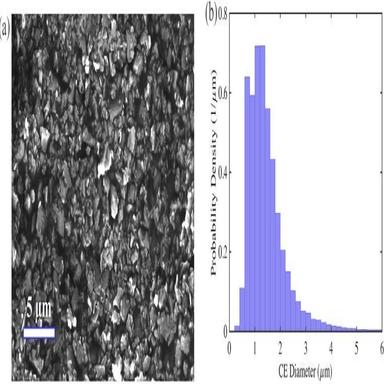
(a) Scanning electron microscope (SEM) micrograph of granular boron carbide powder at as-received state. The average particle size is at sub-micron level with several relatively larger particles. From the transmission electron microscope (TEM) characterization, each particle is a single crystal of boron carbide et al., 2019); (b) Initial particle size distribution; average particle size is around 1 μm which is consistent with (a); the CE Diameter stands for the circular equivalent diameter of t